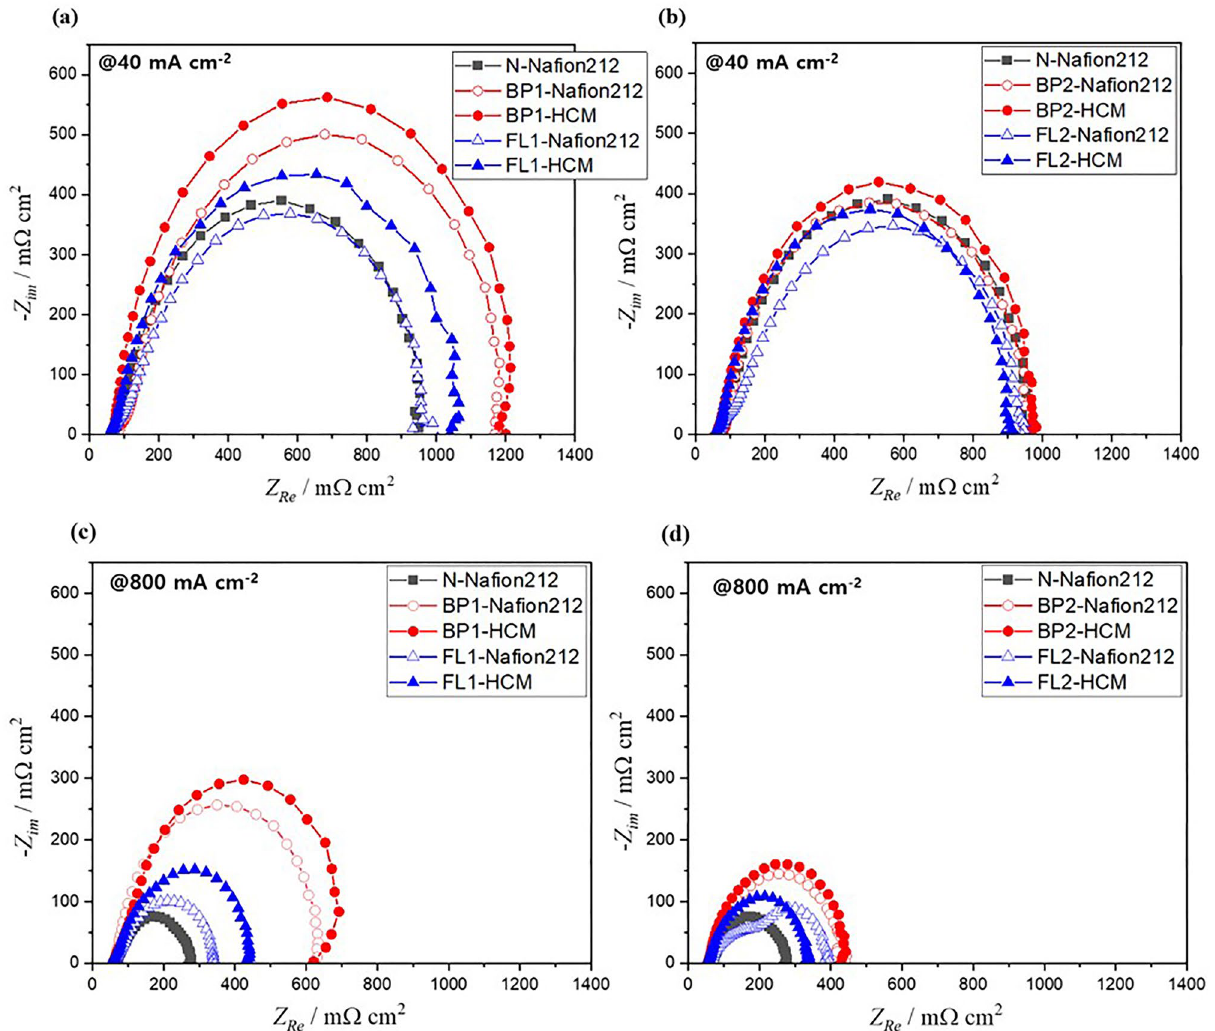
Figure 4. Impedance plots for the MEAs prepared with BP-SPES and FL-SPES ( a , b ) @ 40 mA cm –2 and ( c , d ) 800 mA cm –2 at a cell temperature of 80 °C with 100%